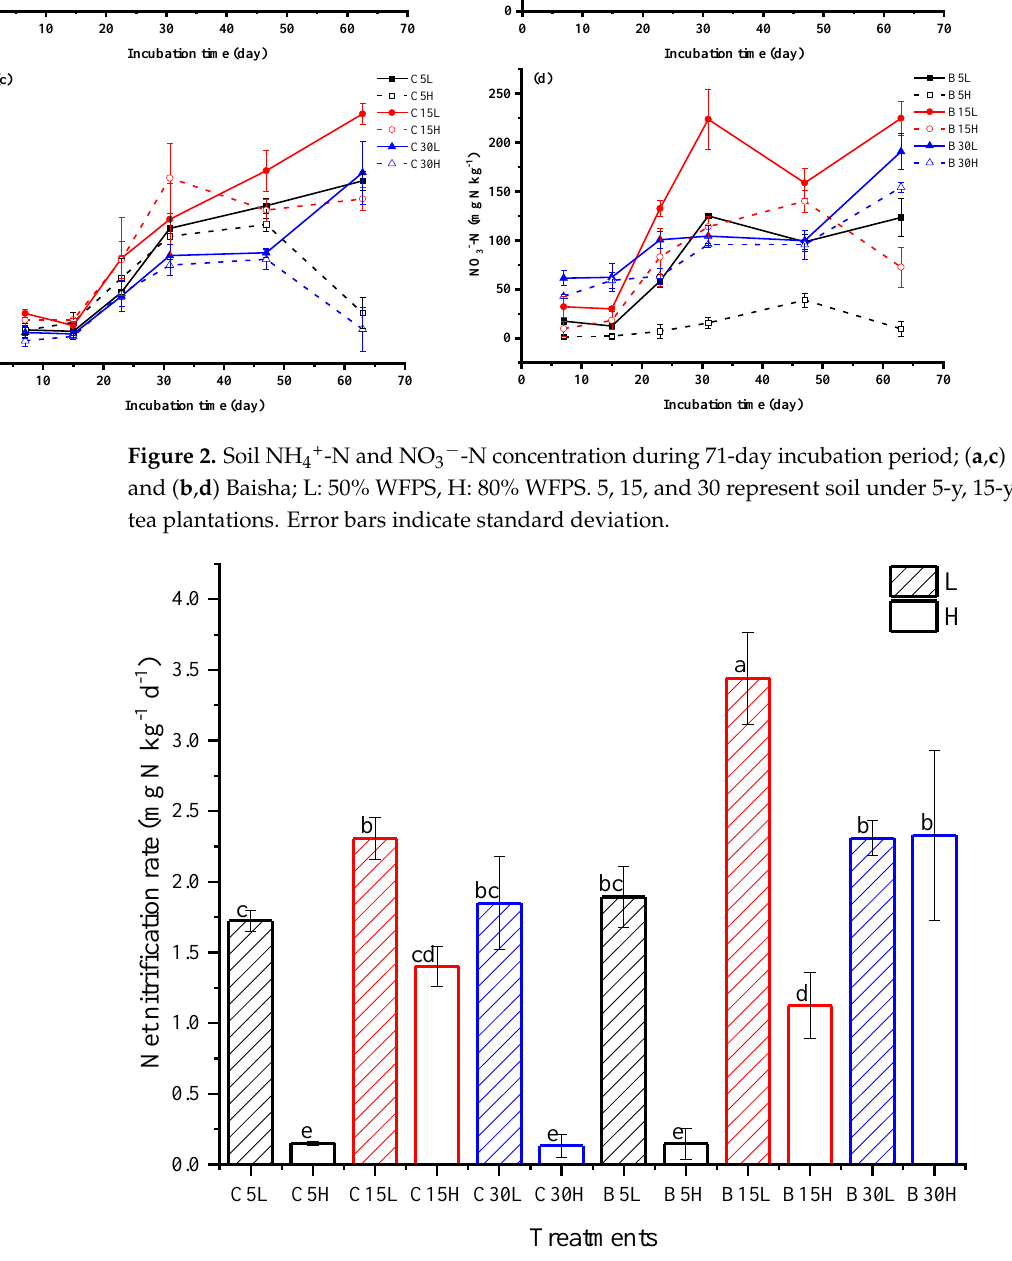
Figure 3. Soil net nitrification rate during the incubation period. C: Changsha tea field soil, B: Baisha tea field soil. L: 50% WFPS, H: 80% WFPS. 5, 15, and 30 represent soil under 5-y, 15-y, and 30-y tea plantations. Error bars indicate standard deviation. Different letters refer to significant differences betweenthe treatmentsat the statistical level of 0.05.